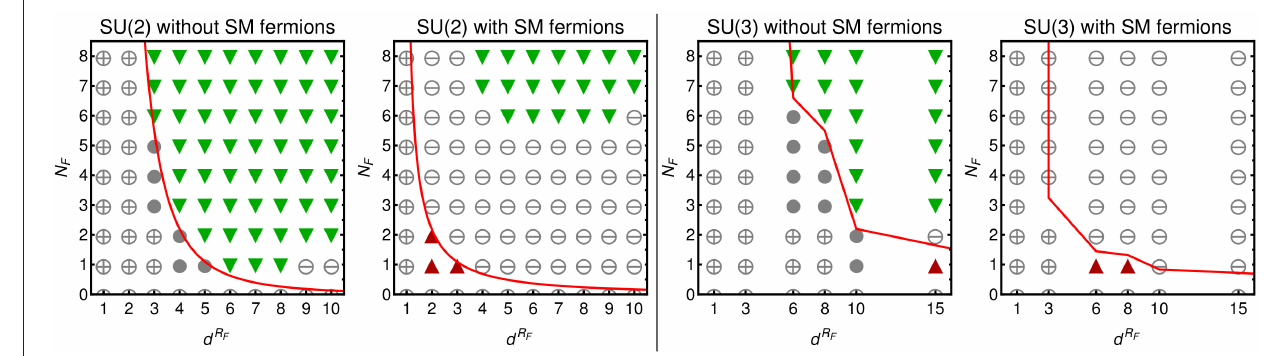
FIGURE 2 | Different phases, i.e., LS ( H ), GY ( N ), BZ ( ), CAF ( ), and CT ( ), of SU(2) and SU(3) gauge groups depending on the number N F and dimension d R F ⊕ ⊖ (cf. Equations 30–31) of the included BSM representations and on whether the SM matter fields are included or not. The thick red curve highlights where the 1-loop contribution vanishes, i.e., B 0. Interacting fixed points can only be controlled perturbatively if they lie in the vicinity of this line. The LS phase recedes from the = perturbatively accessible region whenever the SM fields, i.e., charged matter without or with neglibily small, Yukawa couplings are